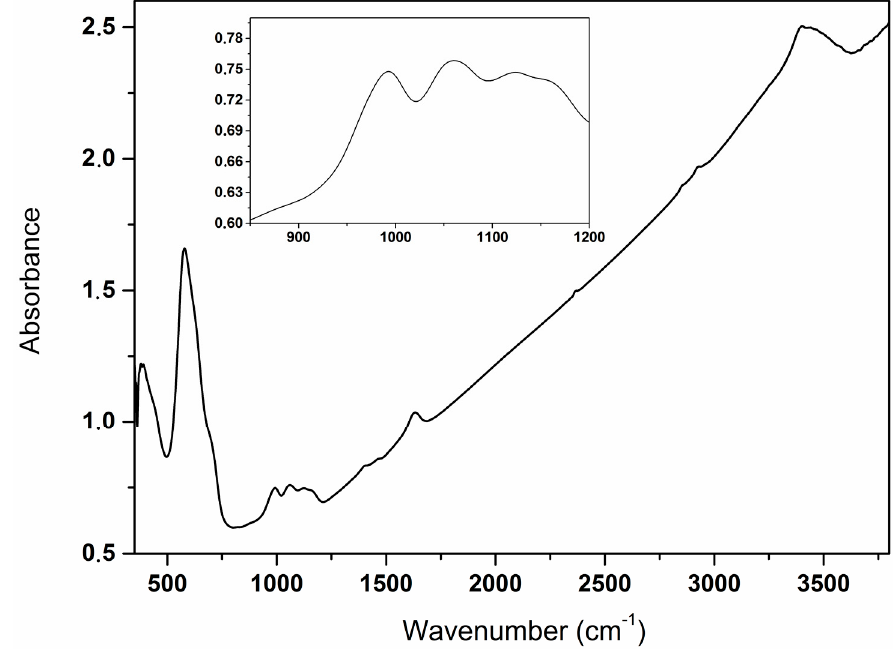
Figure 1. Fourier transform infrared spectroscopy (FTIR) spectrum of 3b (Fe 3 O 4 covered with glycerol phosphate); inset shows an amplified region between 800 and 1200 cm − 1